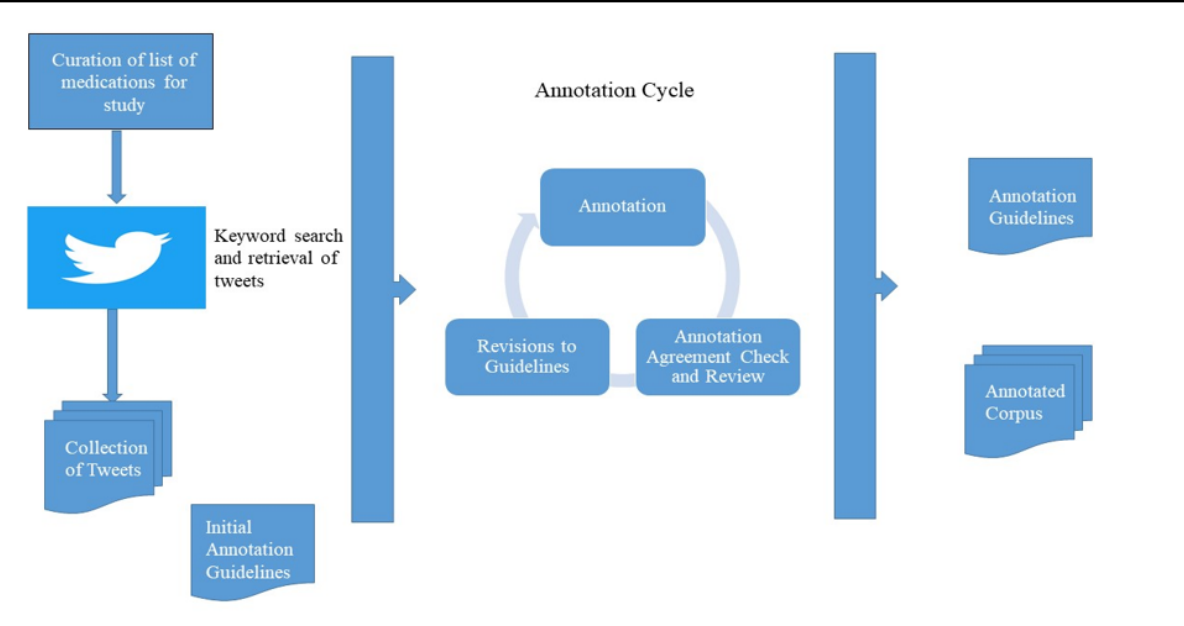
Figure 1. Overview of the creation of the annotation guideline and the iterative annotation